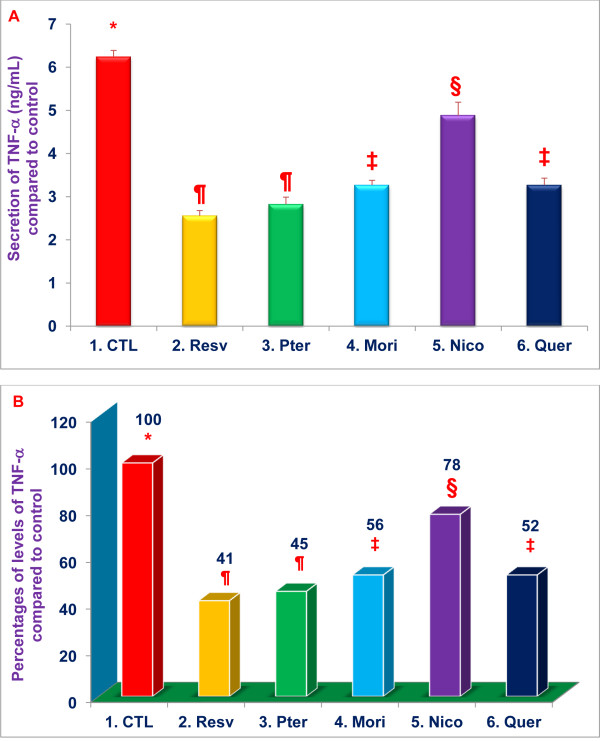
Resveratrol, pterostilbene, morin hydrate, nicotinic acid and quercetin inhibit TNF-α secretion by LPS treated RAW 264.7 cells. TNF-α levels were measured in supernatants of RAW 264.7 treated with resveratrol, pterostilbene, morin hydrate, nicotinic acid, quercetin (16 μM) or medium alone (control) for 1 h, then challenged with LPS (10 ng/well; 400 μL) or medium alone for 4 h. Cell viability exceeded 95% for all treatments. Data are means ± SD, n = 3 per treatment, and triplicate analyses of each sample were performed. Values in a column not sharing a common symbol are significantly different at P < 0.05. CTL = Control (Medium + RAW 264.7 cells + 0.2 % DMSO); Resv = Resveratrol; Pter = Pterostilbene; Mori = Morin hydrate; Nico = Nicotinic acid; Quer = Quercetin-HCL. Figure A = Actual Relative Luminescence Unit (RLU) values. Figure B = Percentages of actual RLU values compared to control.